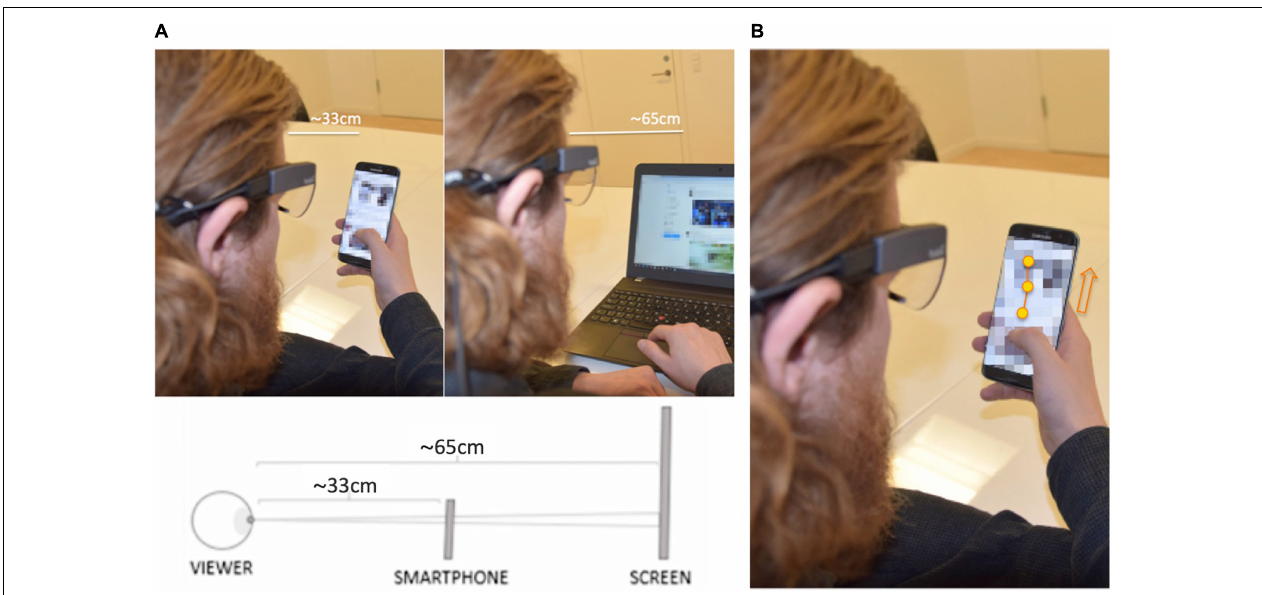
FIGURE 1 | (A) Mock image of stimulus presentation on a smartphone screen versus a computer screen (obtained and published with consent). The default settings for the Tobii I-VT algorithm are based on a stationary setup with the viewing distance of approximately 65 cm. When looking at a smartphone screen the stimulus area is smaller and located at a closer distance, resulting in reduced saccade lengths and velocity of the eye movements. (B) Mock image of smooth pursuit while gazing at a dynamic stimulus (obtained and published with consent). The respondent is scrolling the screen while the gaze is fixated on a moving stimulus object, resulting in smooth pursuit. The eye-tracking system recognizes the movement of the eye and depending on the parameters of the fixation detection algorithm, may classify the gaze samples as saccades, excluding them from the fixation